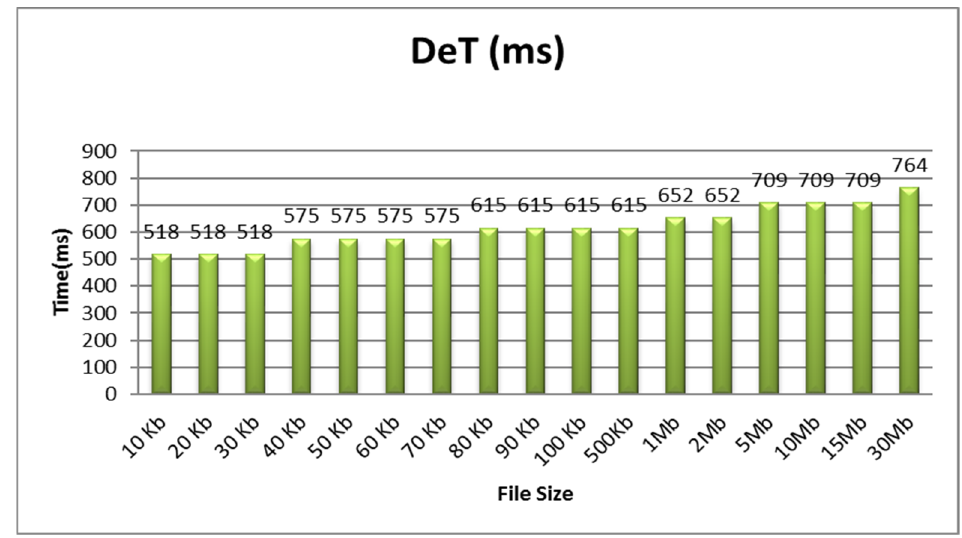
Figure 4. Encryption time.